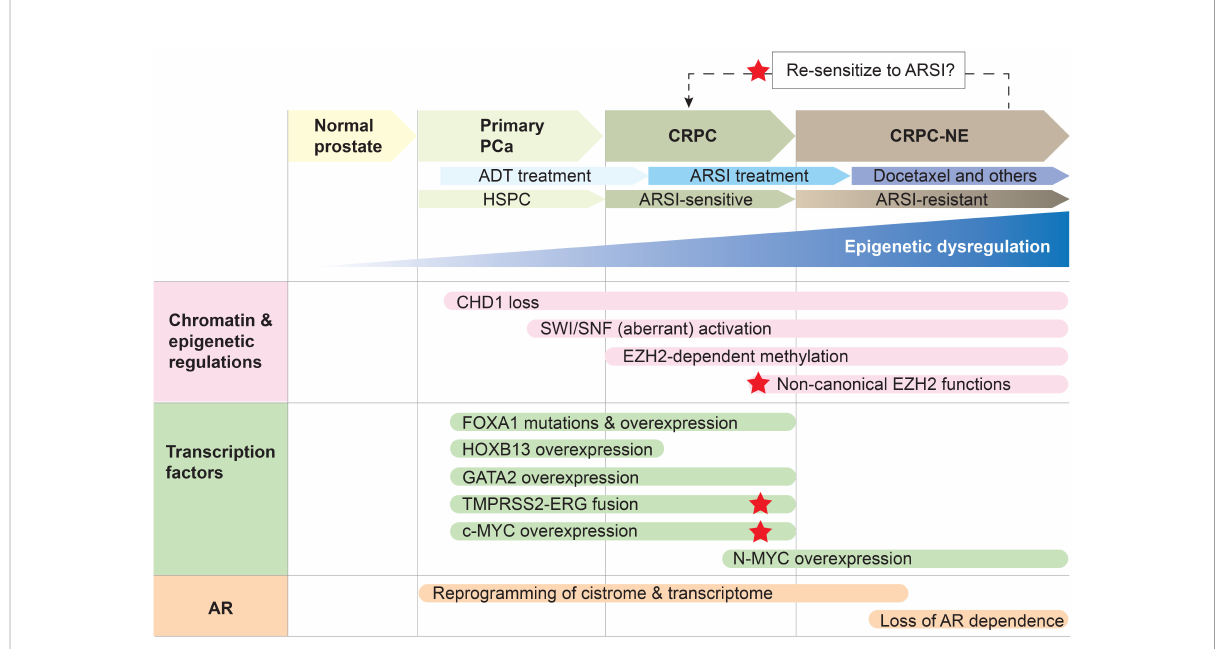
FIGURE 2 Epigenetic dysregulation and concordant aberrant transcription factor activity result in a reprogrammed AR cistrome and transcriptome to drive prostate cancer progression. Primary prostate cancer (PCa) is hormone-sensitive (HSPC) and responds to androgen-deprivation therapy